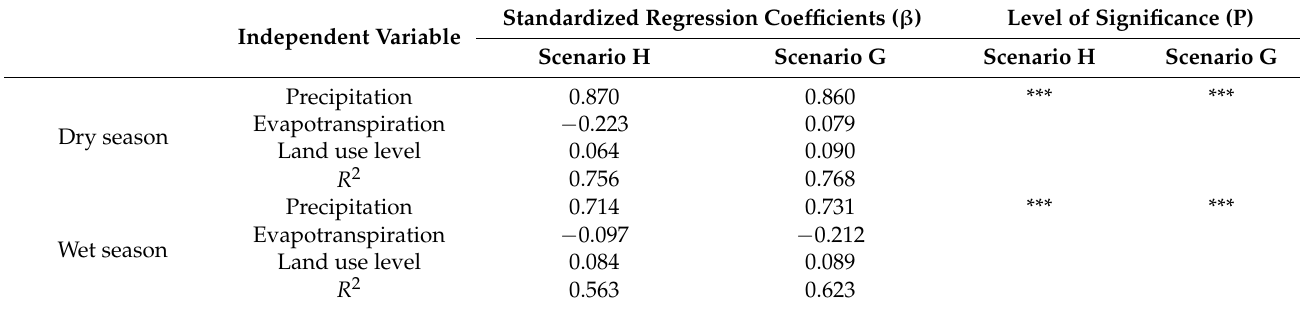
Table 3. Multiple linear regression results for scenarios H and G.